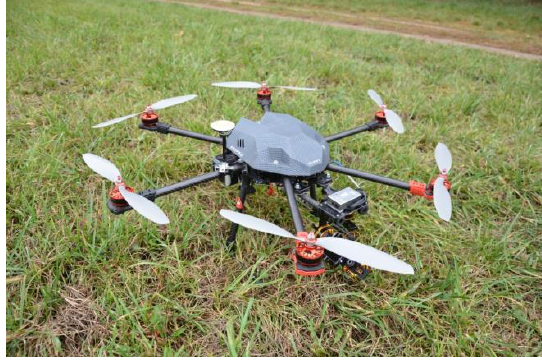
Fig. 4: UAV used for monitoring pond Pohranov, source: authors Measurements must be done several times in different days to obtain a short time series. Time horizons were selected according to the above listed weather conditions and to cover a longer time period, namely: 7. 7. 2015, 18. 7. 2015, 23.